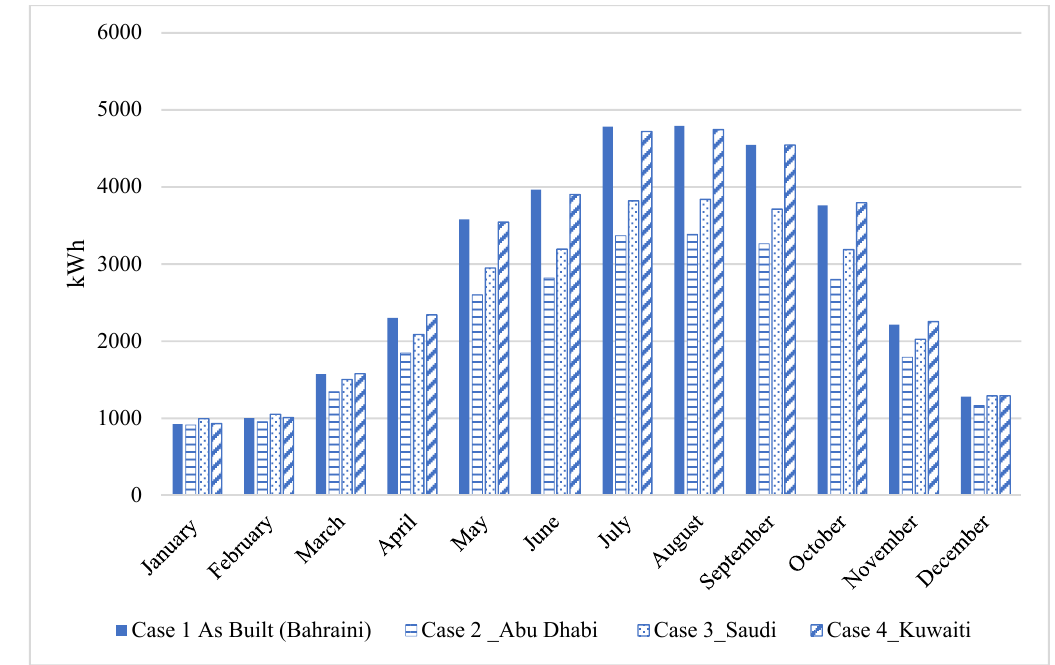
Figure 8. Monthly energy consumption for base Case 1 (Bahraini code), Abu-Dhabi ESTIDAMA 1 code, Saudi code, and Kuwaiti code.